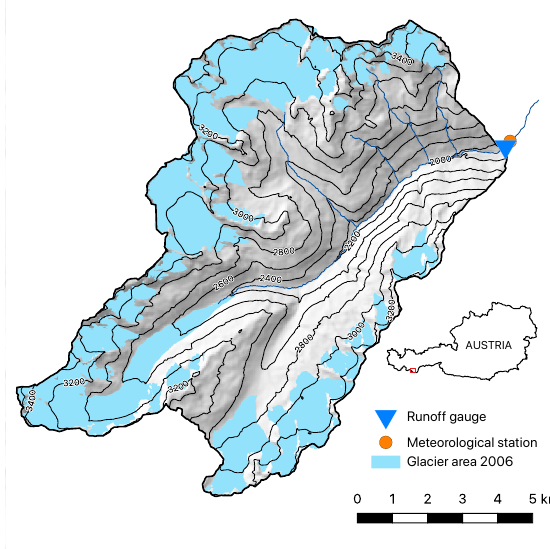
Figure 1. Map of the Rofenache catchment including glacierized areas and the locations of the runoff gauge and the meteorological station in